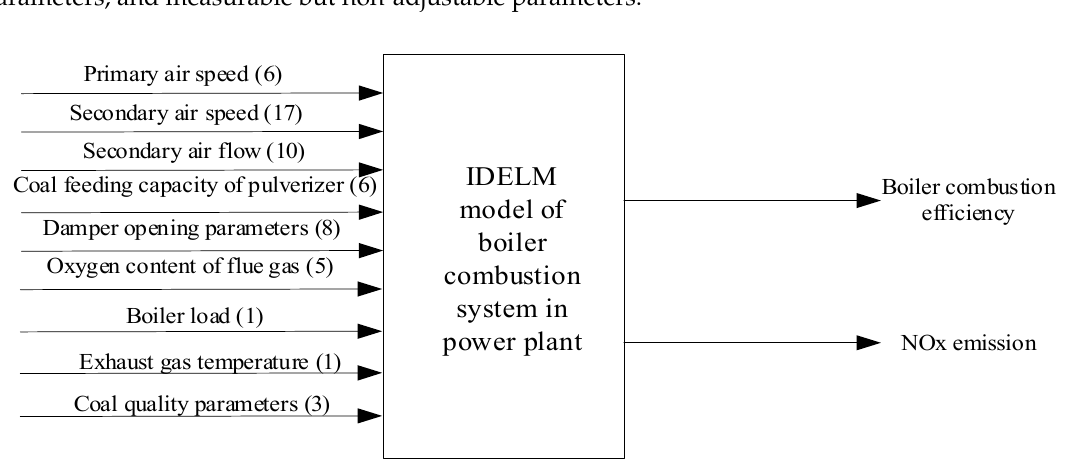
Figure 6. IDELM model of boiler combustion system.